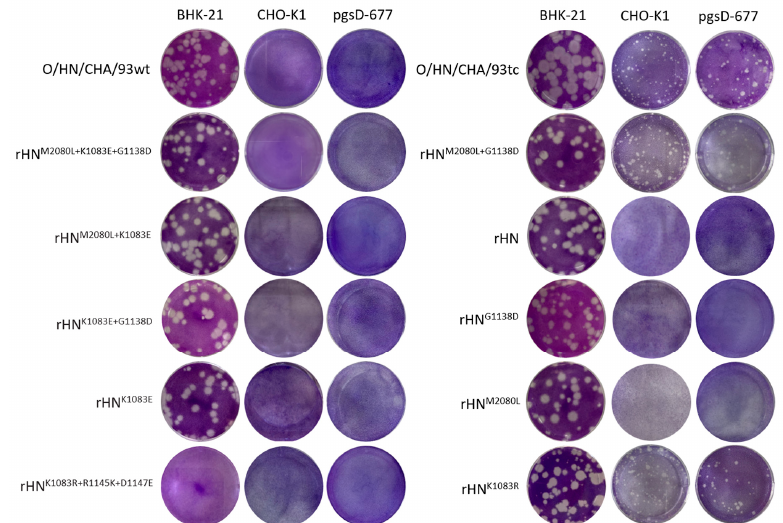
Figure 1. The plaque phenotypes of site-directed mutants of rHN on BHK-21 cells and two CHO cell lines. The procedures of plaque assays for each virus were done as described in the Materials and Methods. O / HN / CHA / 93wt and O / HN / CHA / 93tc could be regarded in parallel as